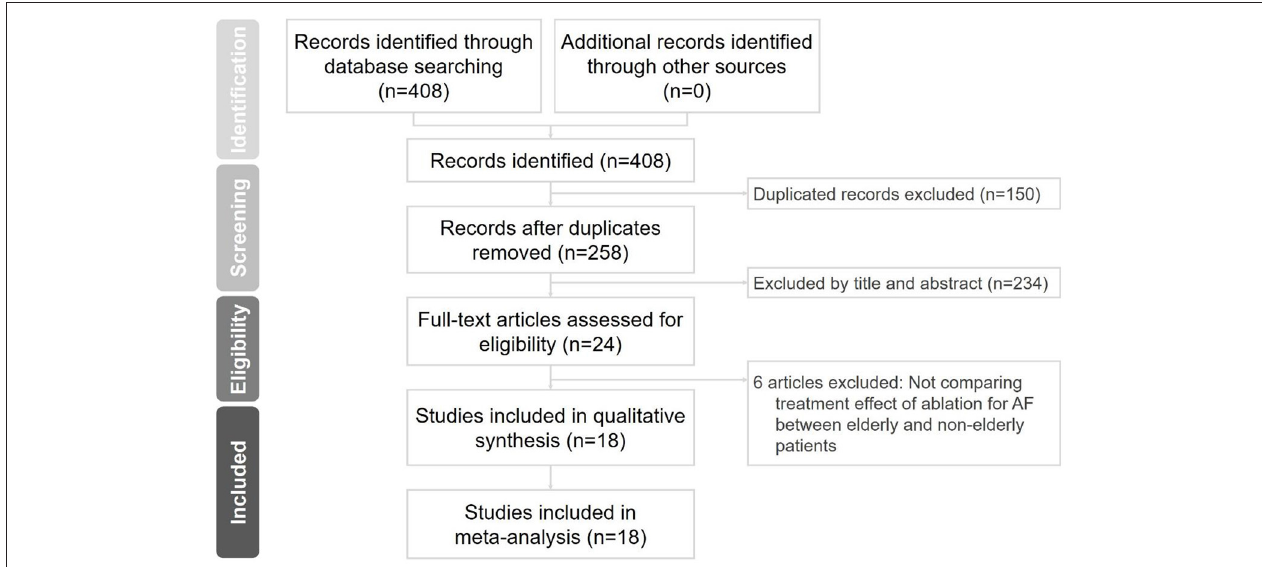
FIGURE 1 | Flowchart of the selection strategy and inclusion and exclusion criteria for this meta-analysis. AF, atrial fibrillation.